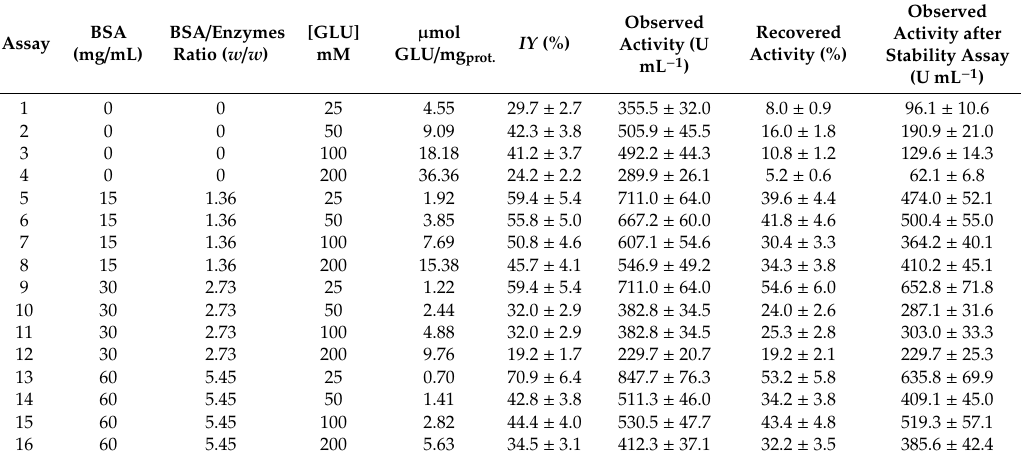
Table A1. Immobilization yield ( IY ) and recovered activity after the stability assay of glucose oxidase (GOD) immobilized by the CLEA technique: influence of the glutaraldehyde concentration (GLU) and BSA / enzymes ratios ( w / w ).